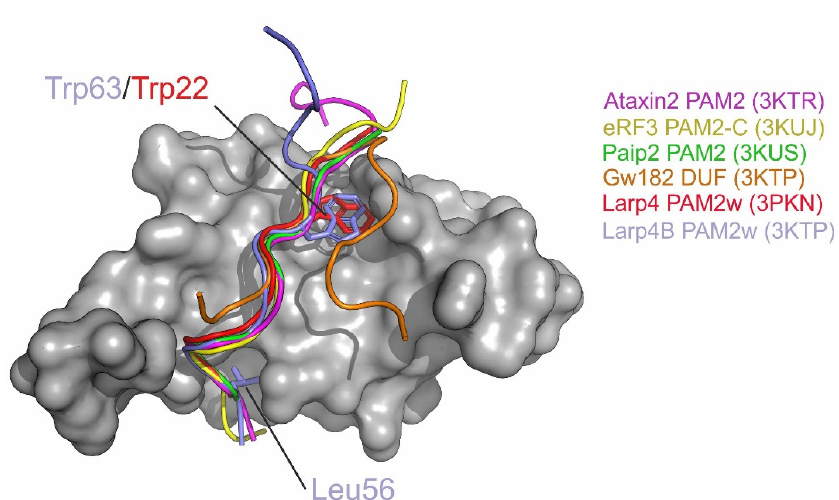
Figure 3. Superposition of the C α -trace of LARP4B–PAM2w (blue, sidechains L56 and W63 shown) with C α -traces of the LARP4–PAM2w (PDB ID 3PKN, red, sidechain W22 shown) and PAM2 peptides from PABP interacting protein (Paip2, PDB ID 3KUS, green), release factor 3 (eRF3 C-terminal motif, PDB ID 3KUJ, yellow) and Ataxin2 (PDB ID 3KTR, pink). The GW182 DUF peptide (3KTP) is depicted in